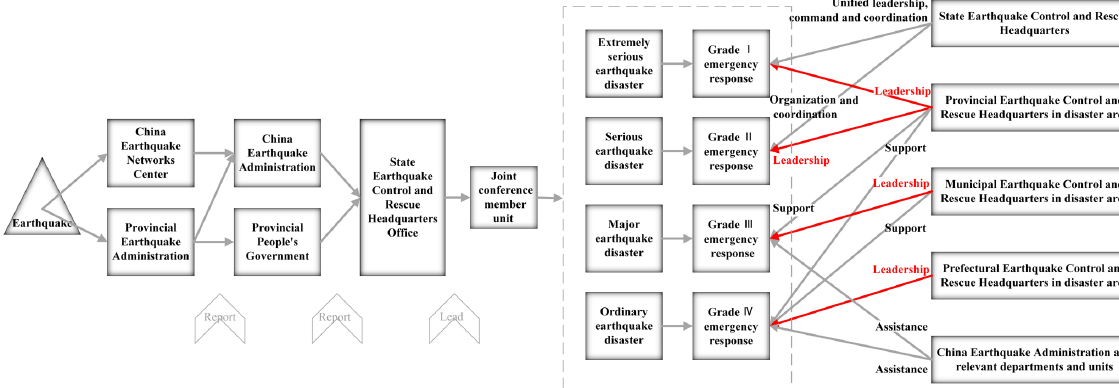
Figure 5. China’s earthquake emergency response command and control